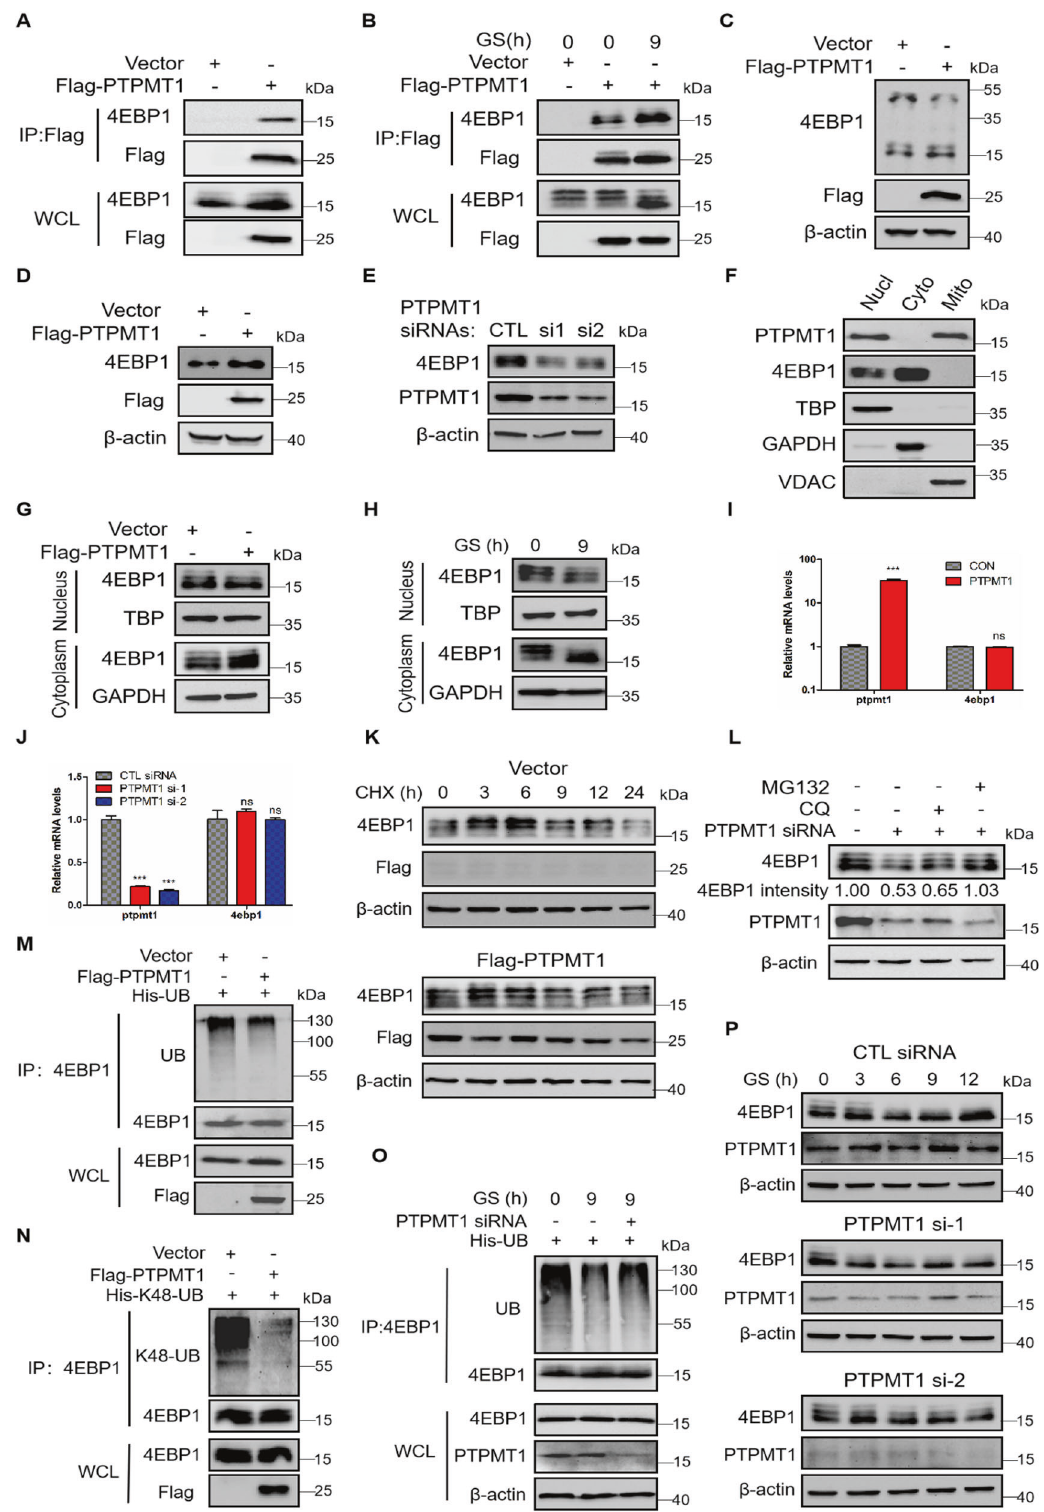
induced upregulation of 4EBP1 protein (Fig. 2P). All the results demonstrated that PTPMT1 dephosphorylated and stabilized 4EBP1 by preventing 4EBP1 from being targeted for ubiquitin- mediated proteasomal degradation under glucose starvation conditions. Cell Death and Disease (2022)